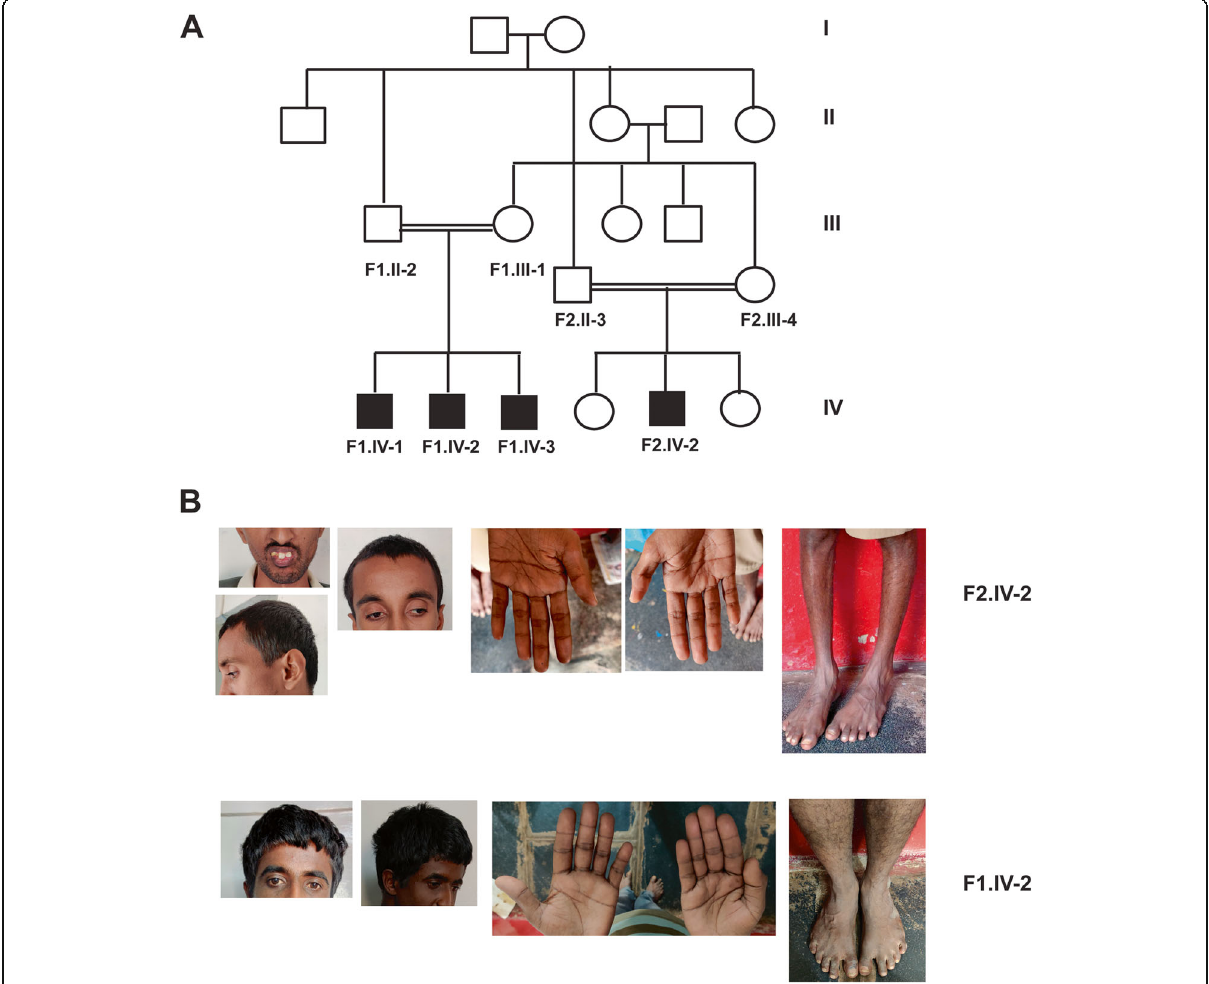
Fig. 1 Pedigree and clinical photographs. a Pedigree depicting affected and unaffected individuals and consanguinity, b Clinical photographs describing dysmorphic features, simian crease and low muscle mass in legs of patient F2.IV-2 and